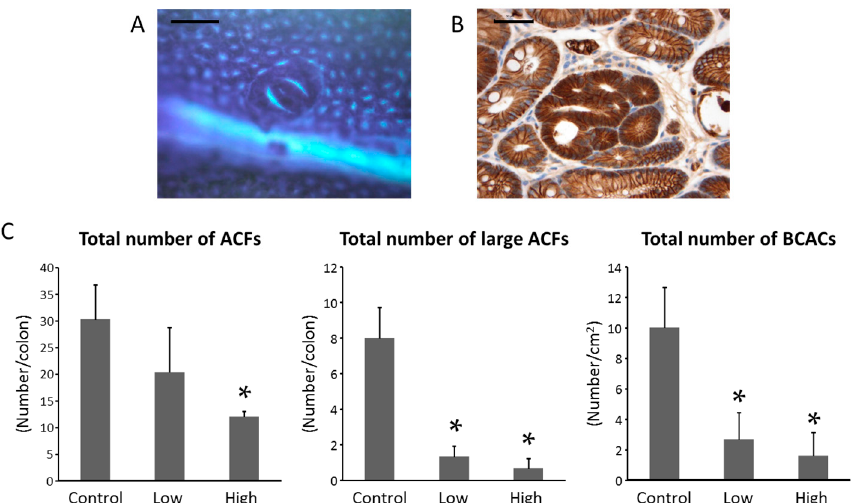
Figure 1. Azoxymethane (AOM)-induced colonic preneoplastic lesions aberrant crypt foci (ACF) and β -catenin accumulated crypts (BCACs) in male C57BL/KsJ- db/db mice. Representative pictures of AOM-induced colonic preneoplastic lesions; ( A ) ACF revealed by methylene blue staining and ( B ) BCACs stained immunohistochemically for β -catenin. Scale bars, 200 µm (left); 50 µm (right); ( C ) The numbers of ACF and BCACs observed in each group. Large ACFs, ACFs with four or more aberrant crypts. Each column represents the mean ± SD ( n = 6 for each group). * p < 0.05 vs. p entoxifylline (PTX)-untreated control group.